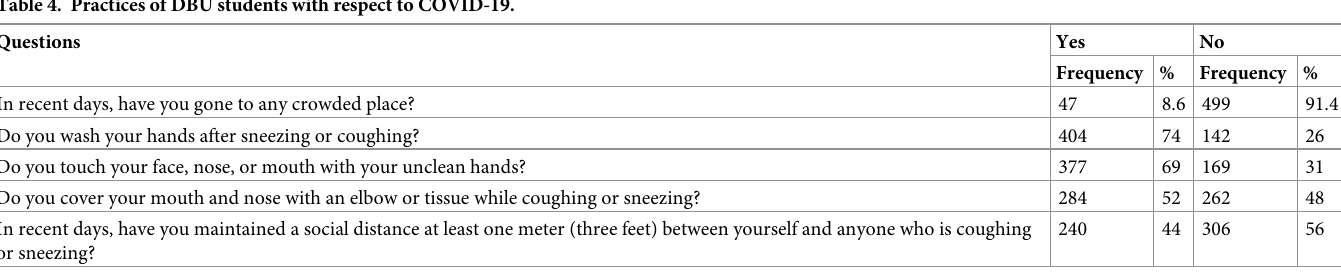
Table 4. Practices of DBU students with respect to COVID-19.